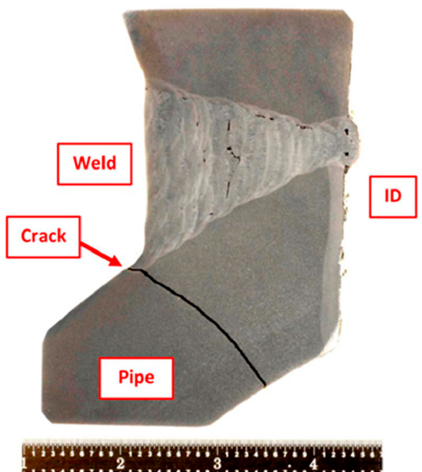
Figure 13. Metallographic section showing in-service cracking at a welded tee piece connection. The scale shown in graduated in inches. scale shown in graduated in